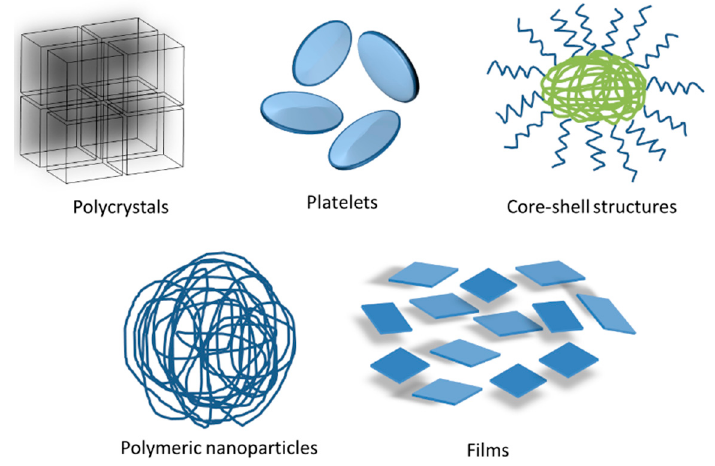
Figure 1. Different FP systems used to enhance the bioavailability of sensitive molecules.